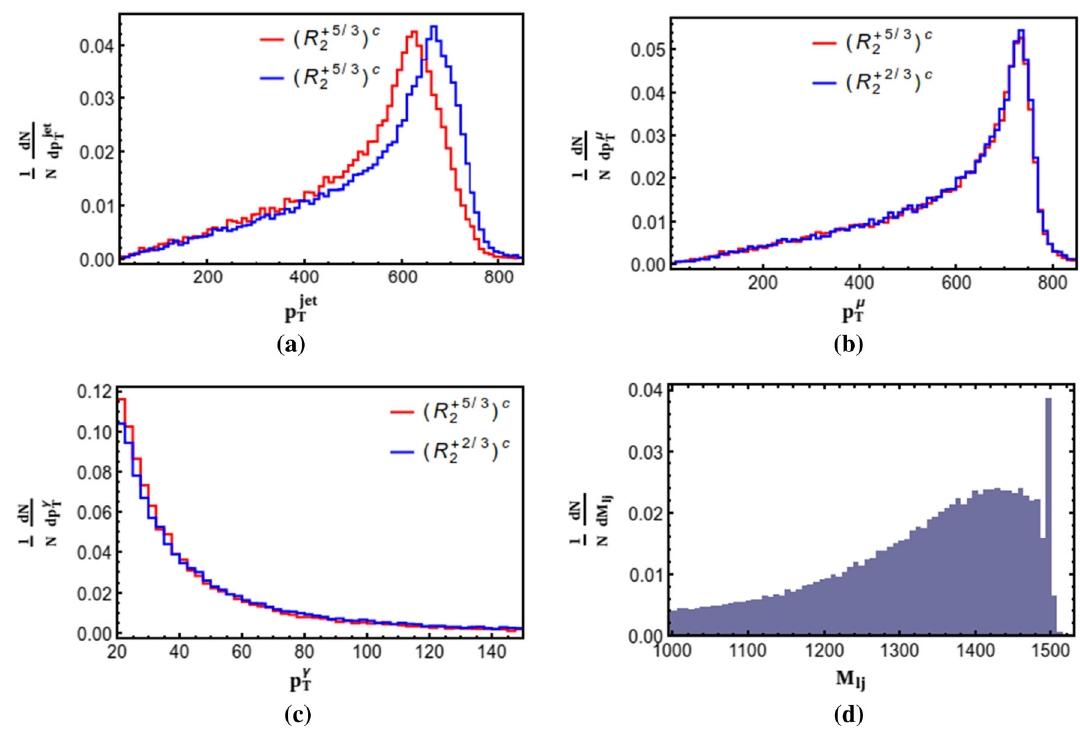
√ s = 2190 . 2 GeV for the scalar-doublet leptoquark R c